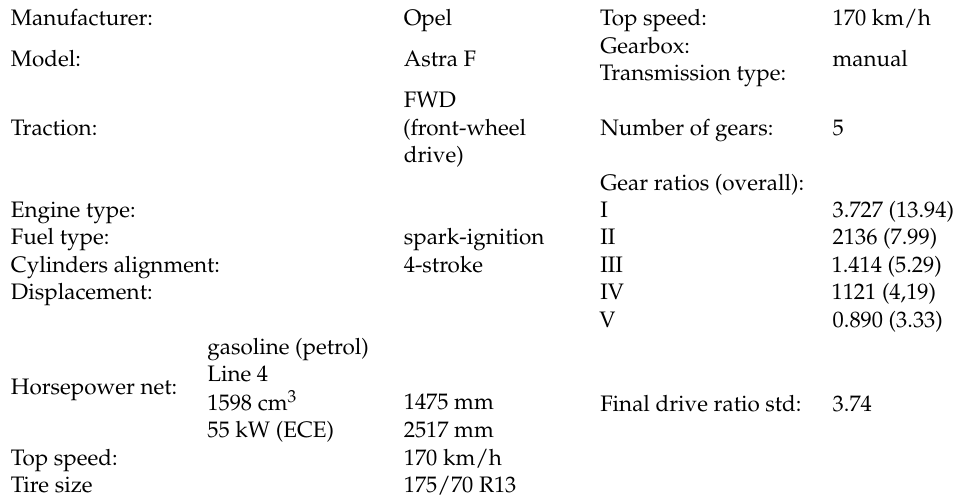
Table 1. Characteristics of researched vehicle and its engine